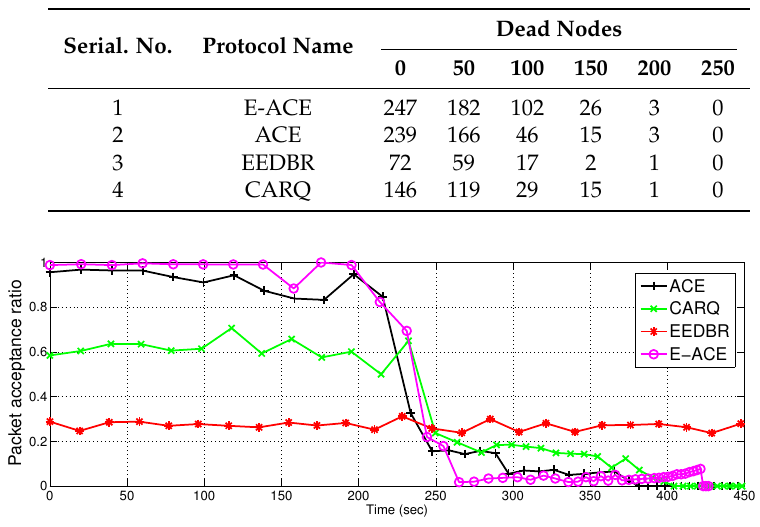
Figure 12. Packet acceptance